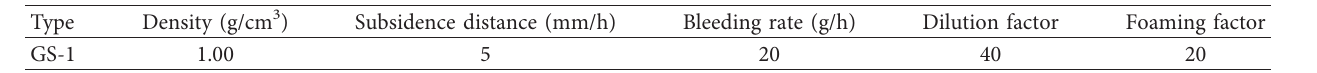
Table 2: Performance parameters of the foaming agent.